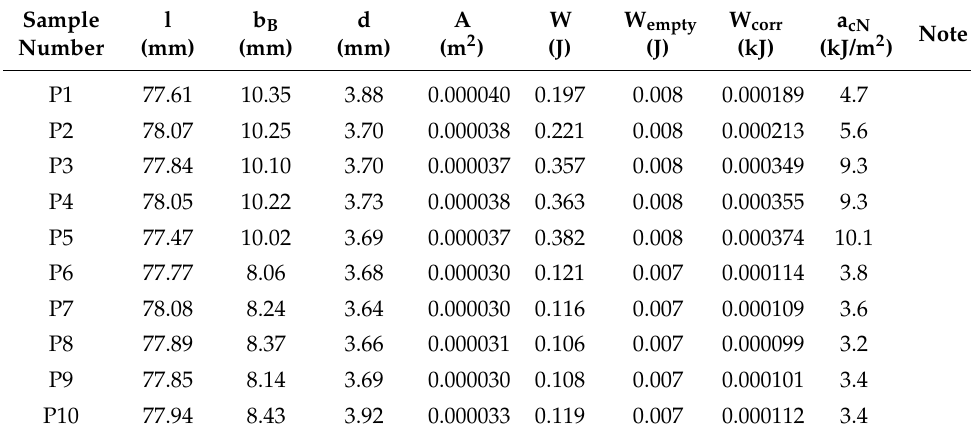
Table A12. Results of the notched impact tests and unnotched impact tests of P_C,PP. Sample